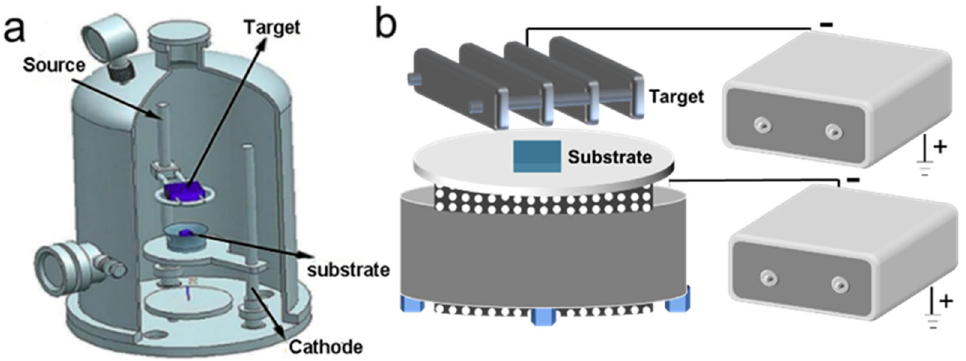
Figure 1. ( a ) The schematic diagram of the DGPSA device. ( b ) Tooling structure of cathode and source in double glow plasma sputtering process. source in double glow plasma sputtering